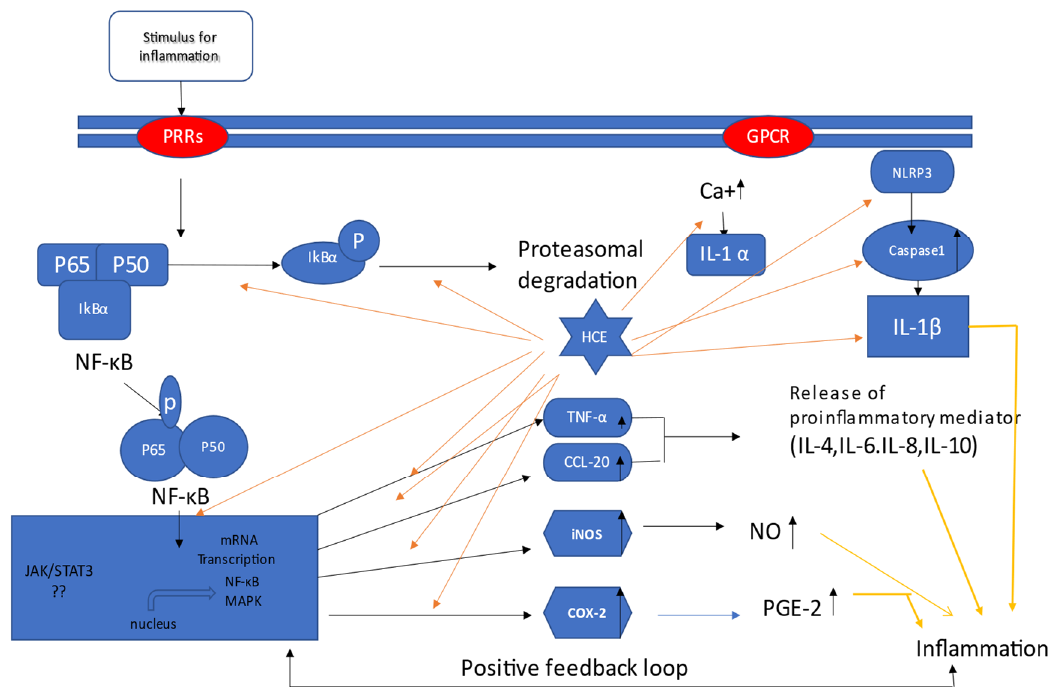
Figure 1. Mechanism of H. cordata acts as an anti-inflammatory agent in vitro; H. cordata suppresses inflammation through various pathways. It blocks all mentioned signaling pathways, resulting in a decrease in the production of inflammatory mediators such as prostaglandins and interleukins. Moreover, H. cordata suppresses inflammation through down-regulation of NF-κB signals and subsequent COX2, INOS, CCL-20, and TNF- α pathways [7].